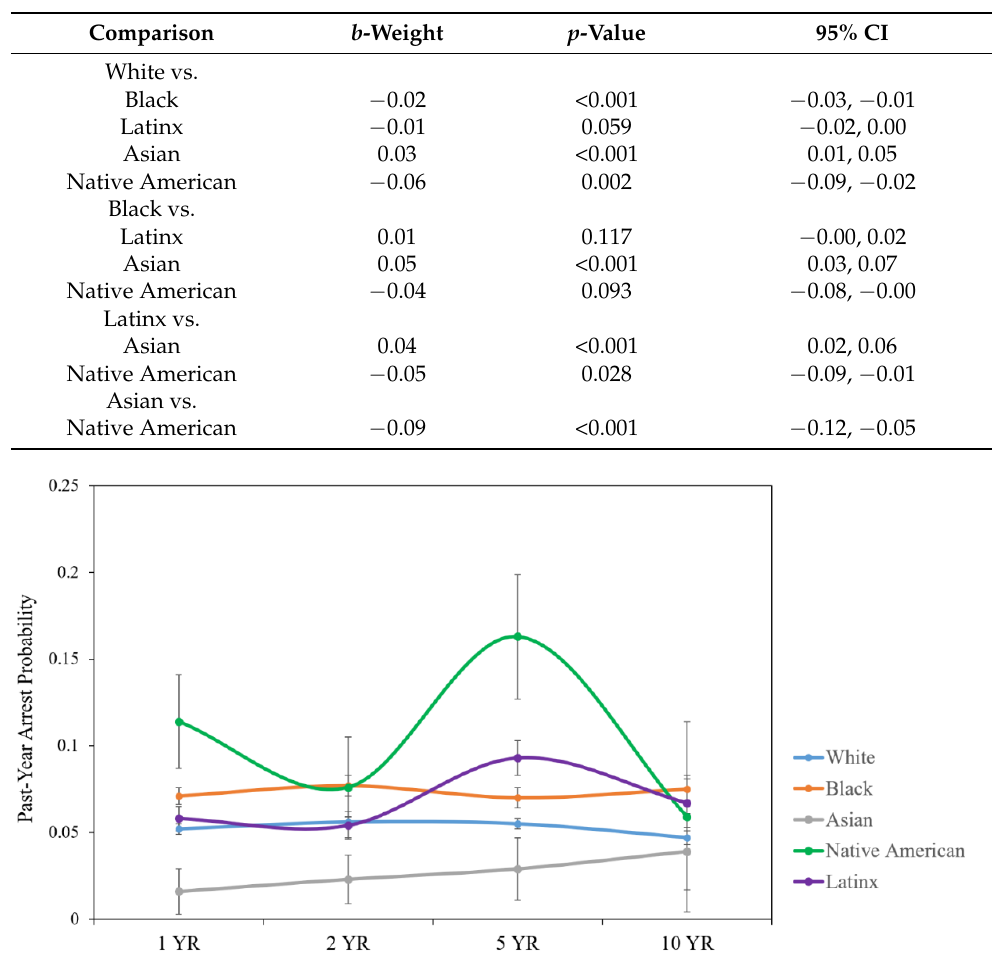
Figure 1. Racial/ethnic differences in past-year arrest probability trajectories over time with unad- justed means and standard error bars.